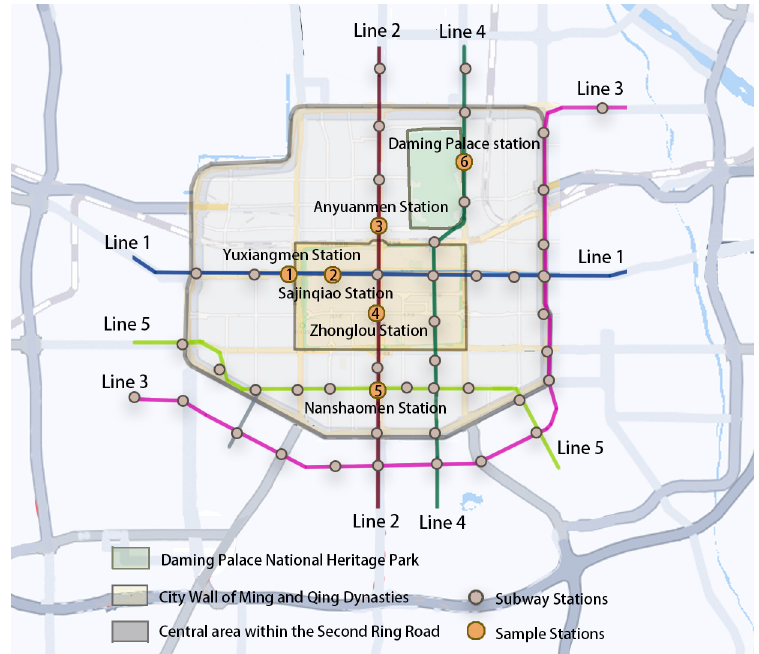
Figure 4. Location of the six sample subway stations in Xi’an City. Table 2. Location information of the six sample subway stations in Xi’an City.